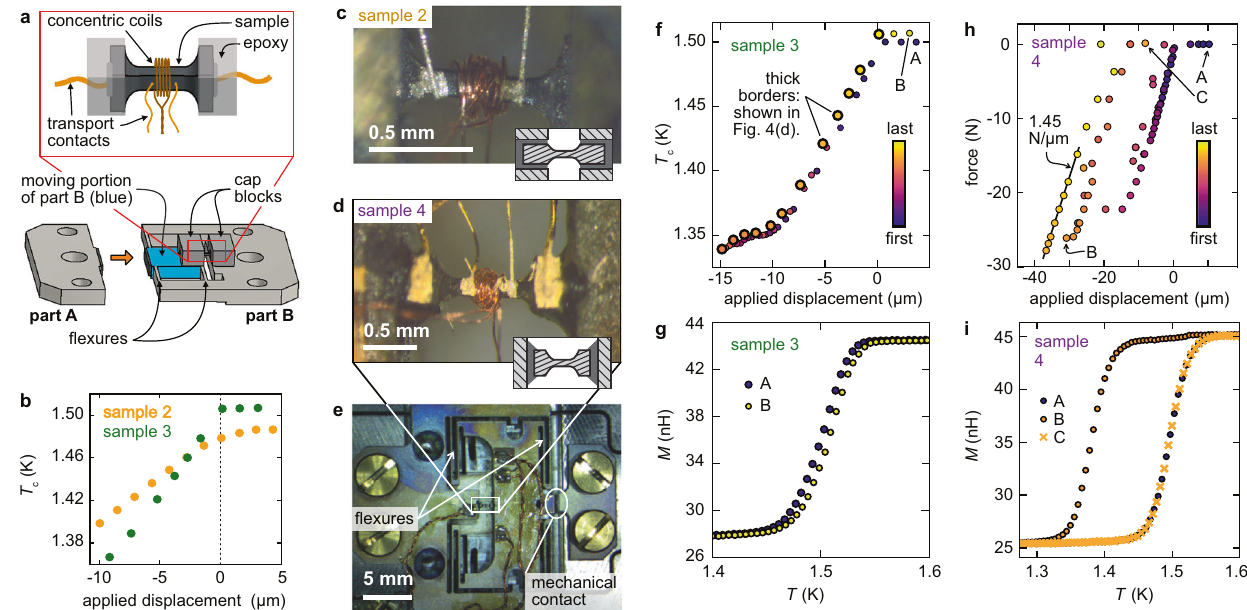
Fig.7|Samplesetup.a Schematicofthesamplecon fi gurationforsamples2and3. Thesesamplesweresculptedintoadumbellshapewithaplasmafocusedionbeam. They were mounted with their ends embedded in epoxy. The cap blocks incorpo- rate slots into which the sample fi ts, and the sample is compressed by bringing parts A and B into contact. b T c versus applied displacement for samples 2 and 3. WhenpartsAandBarebroughtintocontact,forceisappliedtothesample,and T c changes. c , d Photographs of samples 2 and 4. The graphics at the lower right of each panel are schematic cross sections: the end tabs of samples 2 were epoxied